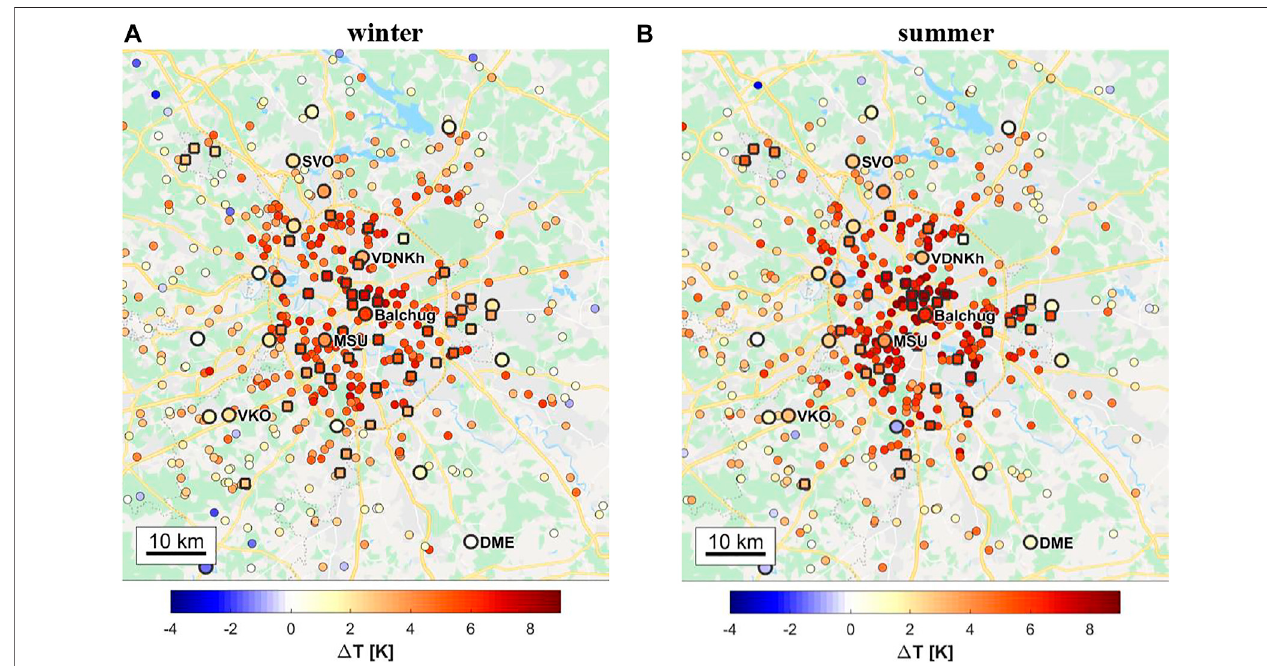
FIGURE 4 | Spatial patterns of the mean urban heat island (UHI) intensity Δ T over the analyzed winter (A) and summer (B) cases. Big circle markers indicate WSs, square markers indicate AAQSs, small circle markers indicate CWSs.